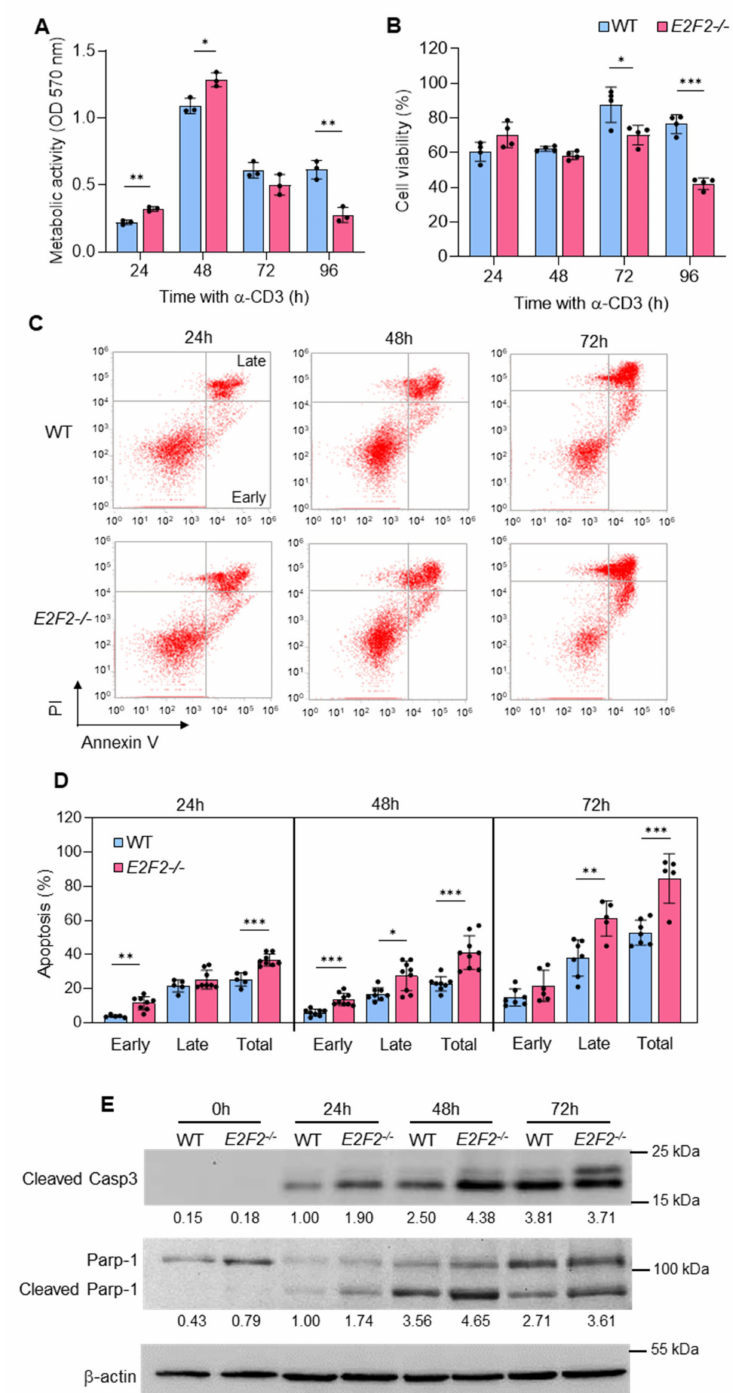
Figure 1. Loss of E2f2 leads to increased apoptosis in TCR-stimulated T lymphocytes: ( A ) Metabolic activity measured by MTT at different times after TCR stimulation with anti-CD3. Results are expressed as optical densities (ODs) at 570 nm from 3 independent experiments. Note that E2f2 − / − cells exhibit enhanced activity at early time-points, but reduced activity at the final time-point. ( B ) Cell viability assessed by Trypan-blue staining of WT and E2f2 − / − purified T lymphocytes after stimulation with anti-CD3 for the indicated times. Data (mean ± SD) are indicated as the percentage of viable cells over the number of cells stimulated from 4 independent experiments. ( C ) Apoptotic death in TCR-stimulated T cells assessed by Annexin V-FITC and Propidium Iodide (PI) staining followed by FACS analysis. Different T-cell populations were distinguished as follows: early